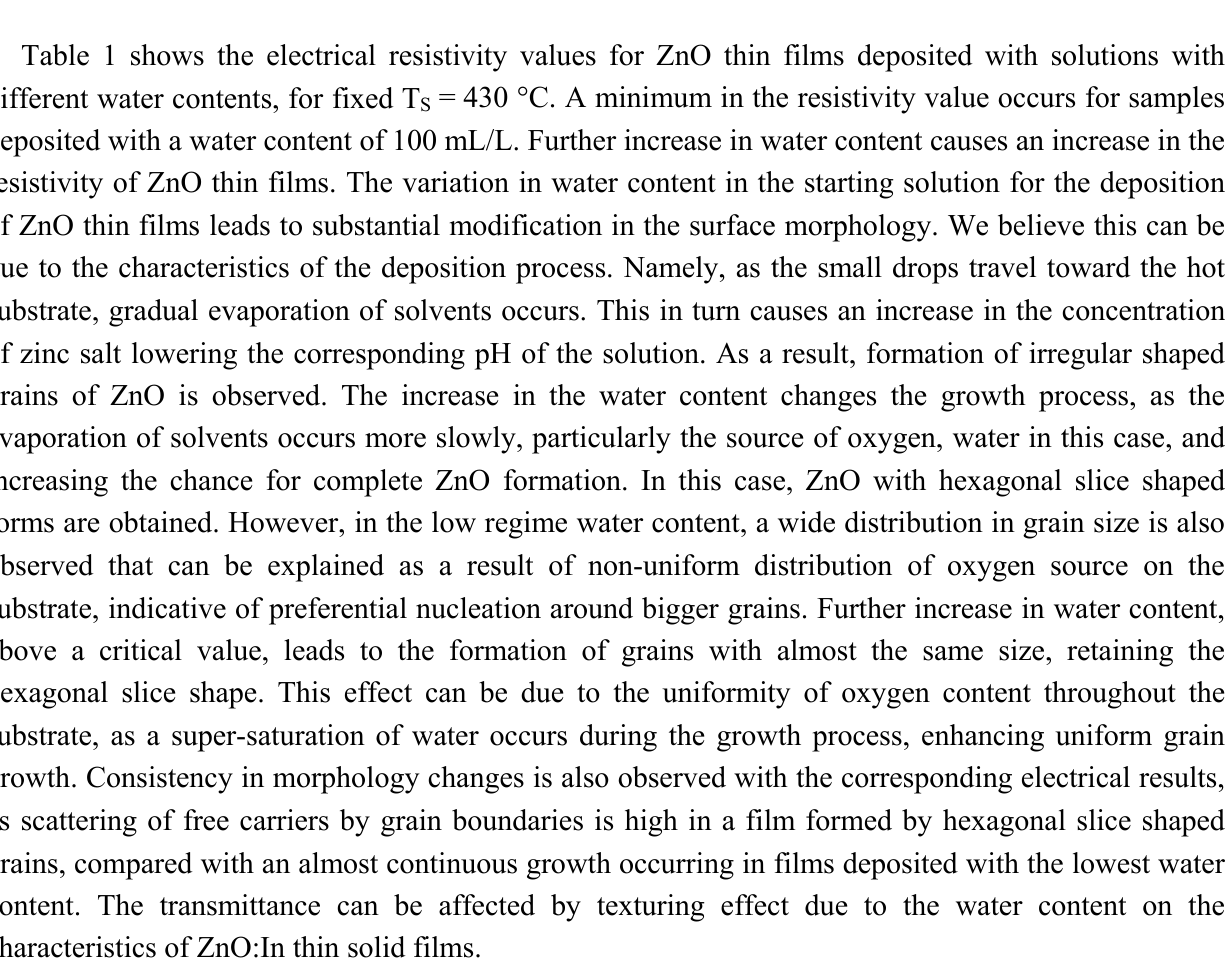
Table 1. The electrical resistivity and the band gap values for ZnO:In thin films deposited with solutions with different water content, for fixed TS = 430 °C. V = Total volume of H V Total 2